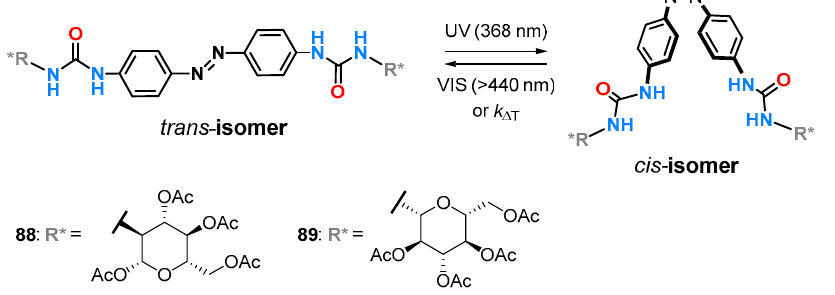
Figure 31. Photoswitchable symmetrical sugar-decorated urea-azobenzene receptors 88 and 89.